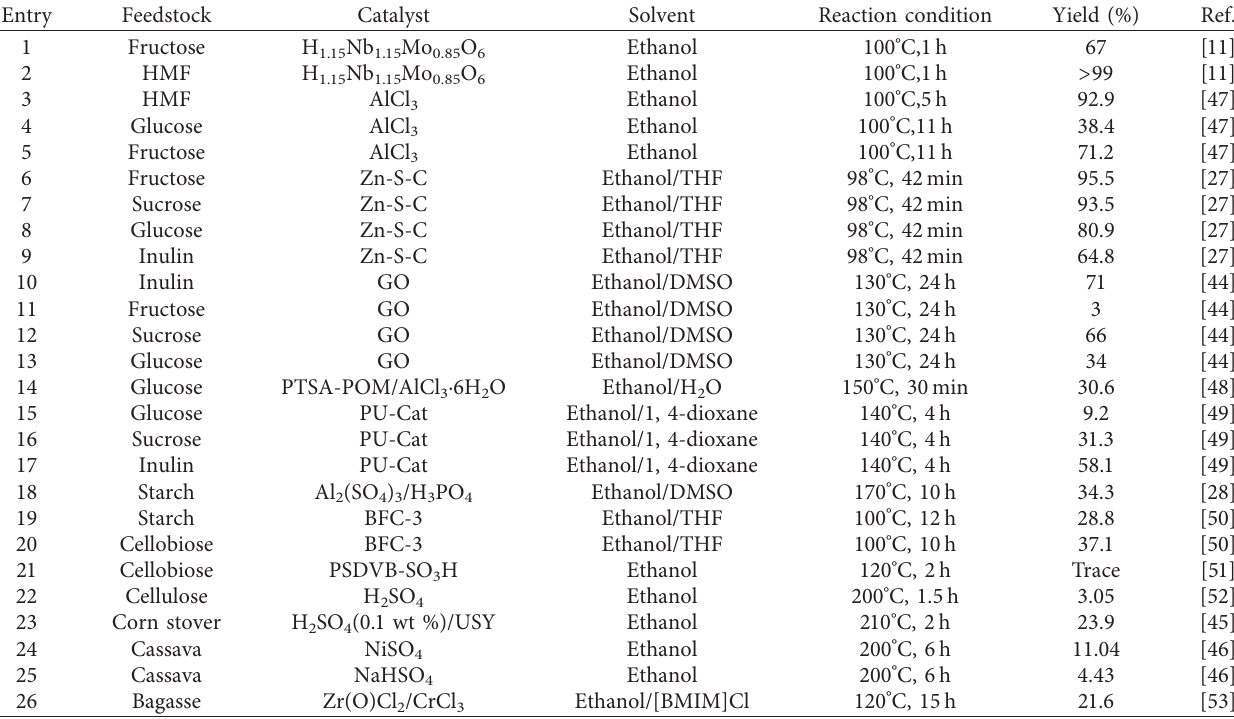
Table 1: Catalytic preparation of EMF from various feedstocks.